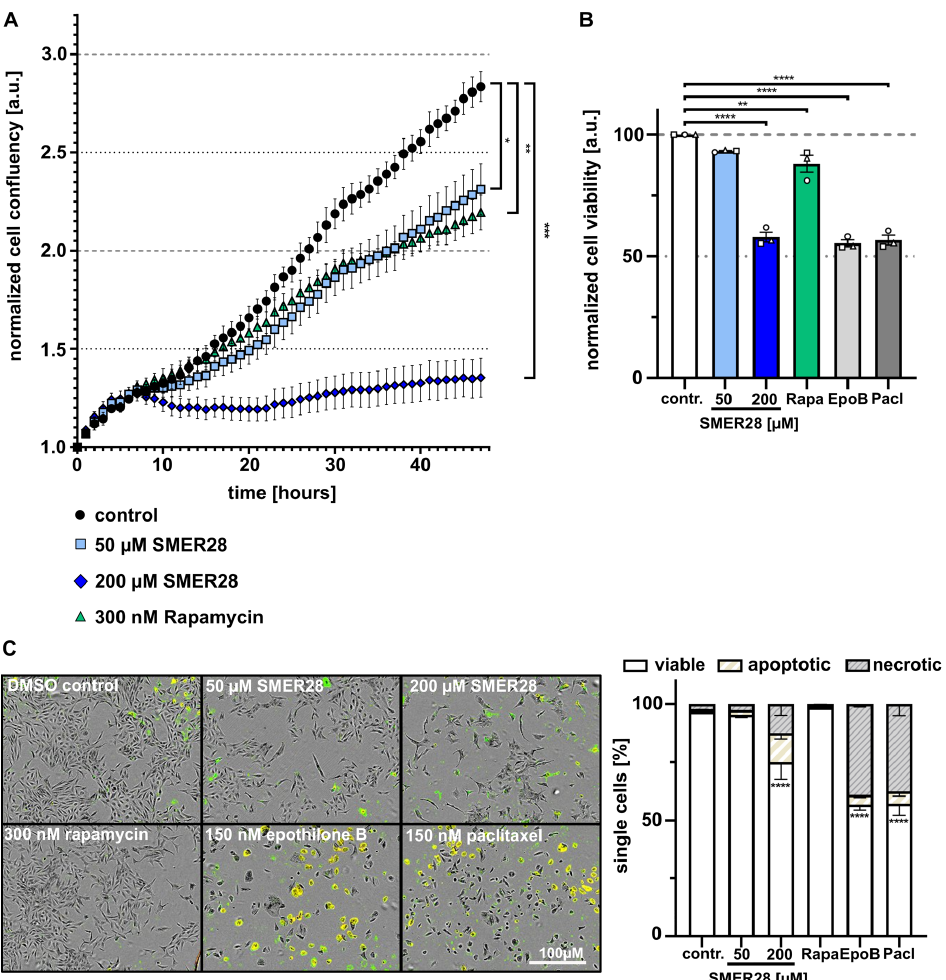
Figure 2. SMER28 treatment inhibits cell proliferation in a dose-dependent manner. ( A ) U-2 OS cells were treated as indicated and immediately recorded by phase contrast imaging for 47 h. The graph shows the mean confluence ± s.e.m. from at least four independent experiments with ≥ 4 replicates. * p < 0.05, ** p < 0.01, *** p < 0.001, two-way ANOVA. ( B ) Cell viability assay (CellTiter-Glo) of U-2 OS cells treated as indicated for 48 h. Data are means ± s.e.m; n = 3. ** p < 0.01, **** p < 0.0001, two-way ANOVA. ( C ) U-2 OS cells were treated for 48 h, as indicated, stained with propidium iodide (PI) and annexin V Alexa Fluor 488 and imaged by phase contrast and fluorescence microscopy. Images show overlays after 48 h, the graph shows quantifications. Cells were categorized as viable versus apoptotic (green fluorescence-positive) or necrotic (green and red fluorescence-positive). Data were collected from three independent experiments and represent means ± s.e.m. **** p < 0.0001, two-way